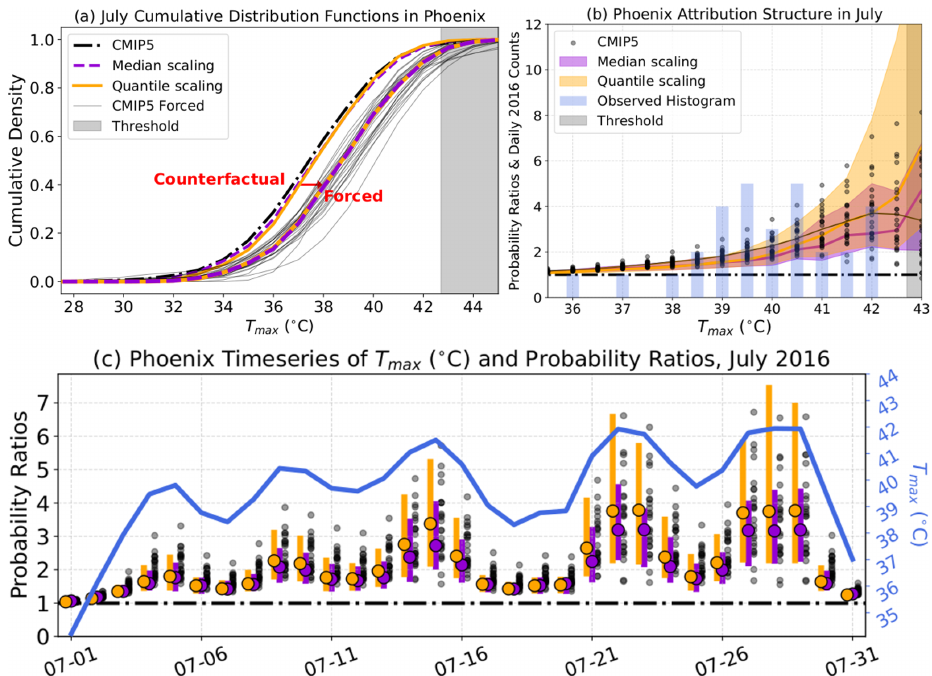
Figure 3. Application of the attribution framework to July 2016 in Phoenix, Arizona, USA. (a) Counterfactual (left curves) and forced (right curves) empirical cumulative distributions functions of T max ; distributions are derived from the median-scaling (purple dashed curves), quantile-scaling (orange dashed curves), and CMIP5 model-based methods (black and gray curves). (b) July probability ratios calculated with each method, along with the observed July 2016 histogram of Phoenix T max . (c) Daily probability ratios (unitless) calculated with each method and observed T max ( ◦ C; blue curve) for each day in Phoenix during July 2016. Purple and orange dots and bars in panels (b) and (c) show the median and 95% confidence intervals for the observation-methods, respectively. Each black dot shows the PR of an individual model from the CMIP5 ensemble. Light-black shading in panels (a) and (b) represents the region of maximum temperatures above which PRs are not assessed with our framework (see the text). The black dashed line at 1.0 is the boundary above which the probability of exceedance is greater in the human-forced climate than the counterfactual